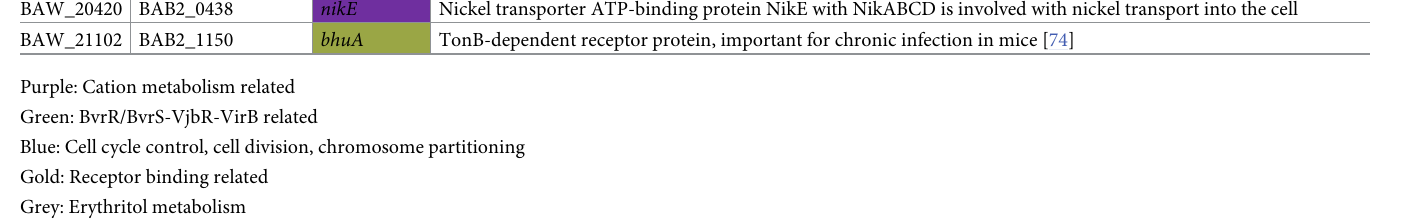
PLOS ONE | https://doi.org/10.1371/journal.pone.0274397 September 21,